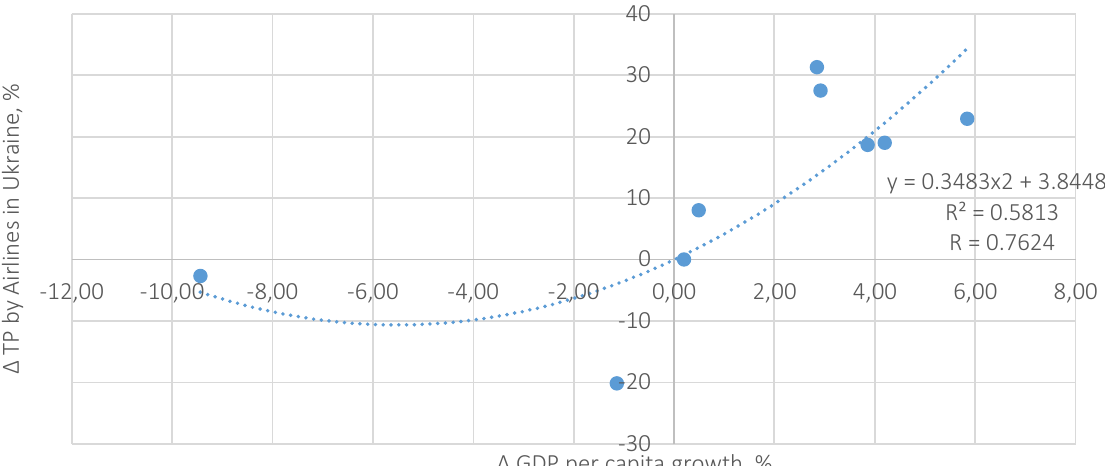
Figure 1. The relationship of the passenger transported by airlines in Ukraine and the GDP per capita growth rate of Ukraine during 2010–2018,